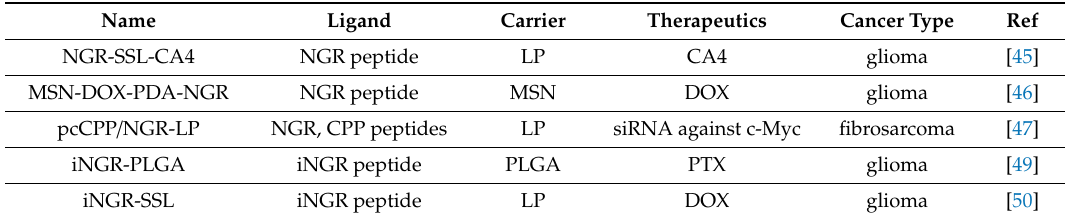
Table 2. NGR-modified